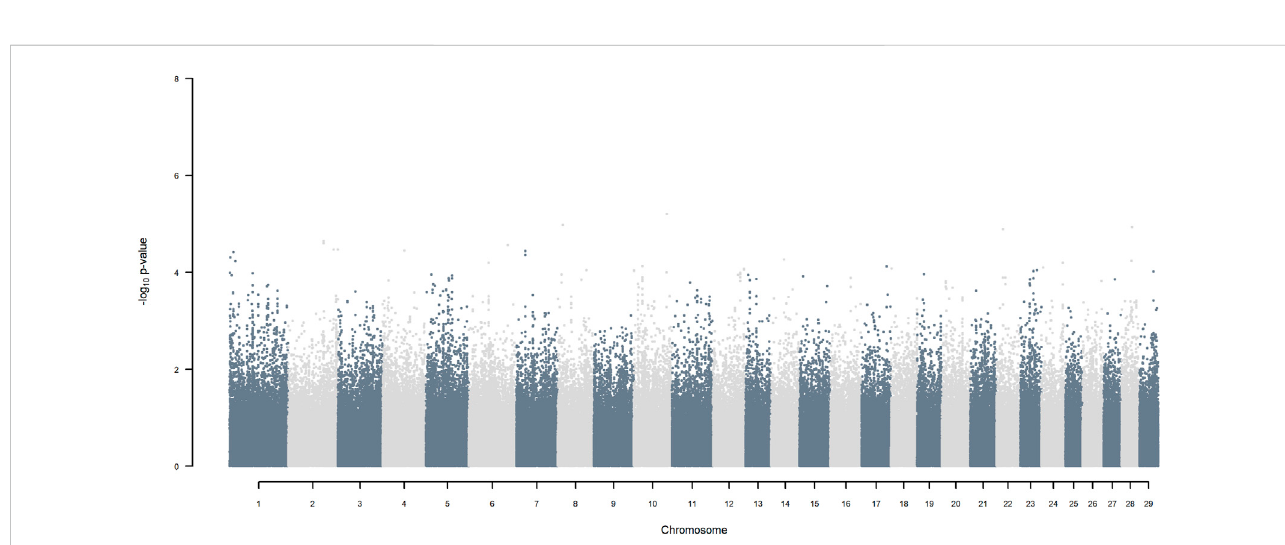
FIGURE 4 Manhattan plot of GWAS (Model 2) for SNP alleles of indigenous origin using SNP alleles of indigenous and of exotic origin that had a MAF > 1%.